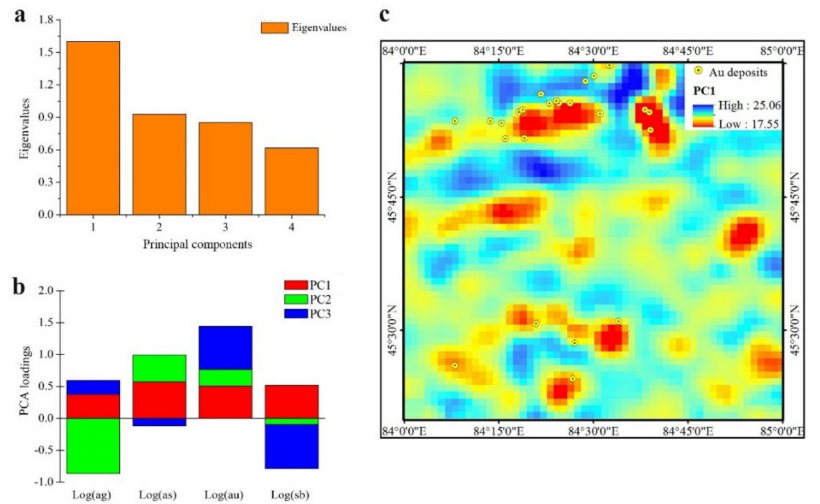
Figure 4. PCA results for the geochemical dataset: ( a ) Scree plot of the principal component (PC1– PC4) eigenvalues for singularity indices of ore-forming elements; ( b ) loadings on principal compo- nents (PC1–PC3); ( c ) PC1 scores generated by singularity indices of ore-forming